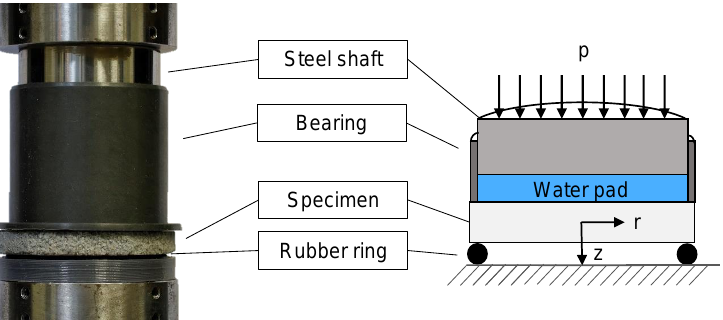
Figure 7. Bi-axial bending test setup. A circular disc specimen is placed on a rubber ring and loaded with a surface pressure through a water-filled pad. The resulting bi-axial stresses can be calculated with plate